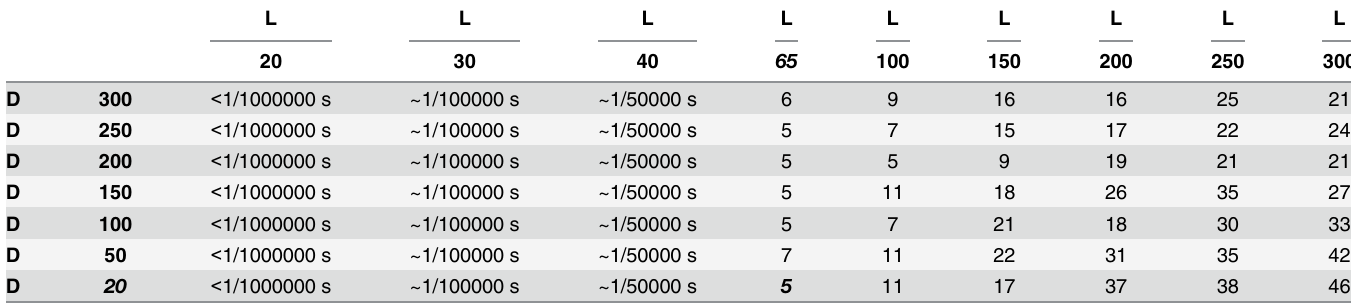
Table 2. Simulation results for a 5,000-ms period at 500 photons/s and a threshold of 8. The average values over 6 trials are given. L indicates L window , D indicates D window .